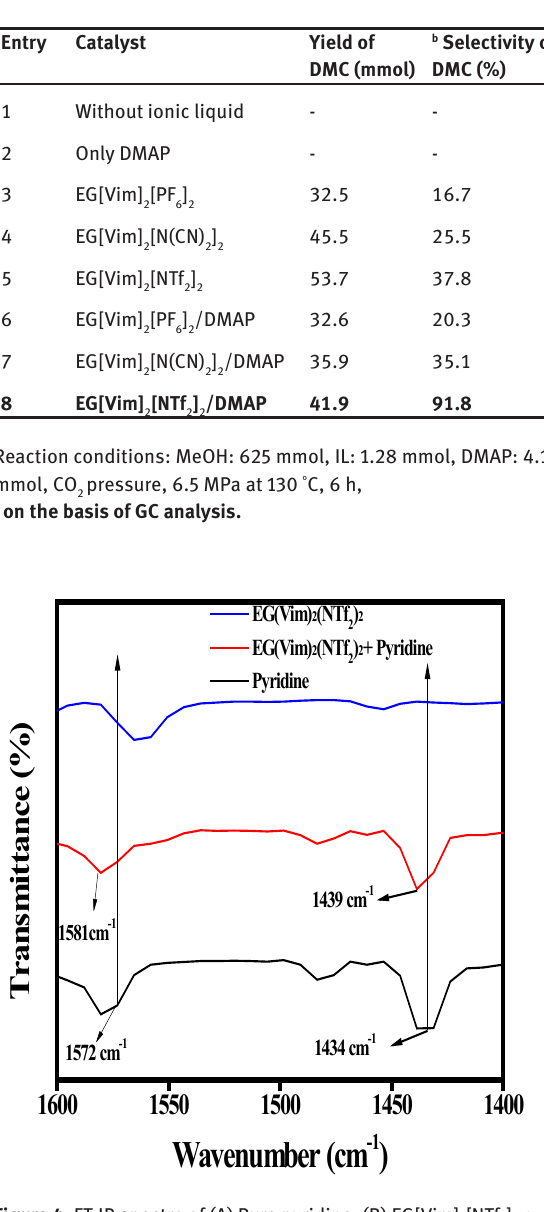
Figure 4: FT-IR spectra of (A) Pure pyridine, (B) EG[Vim] pyridine (2:5 ratio), (C) EG[Vim]